Question: Write a caption explaining this figure to a reader.
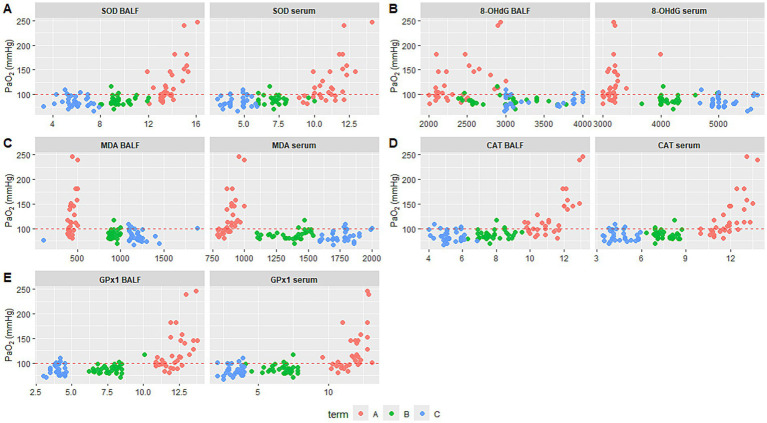
Answer: Repeated-measures correlations between arterial oxygen tension (PaO 2 ) and oxidative stress markers and antioxidant enzyme concentrations in serum and bronchoalveolar lavage fluid (BALF). Correlations are shown for (A) superoxide dismutase (SOD), (B) 8-hydroxy-2′-deoxyguanosine (8-OHdG), (C) malondialdehyde (MDA), (D) catalase (CAT), and (E) glutathione peroxidase 1 (GPx1). Measurements were obtained at three time points: within 6–8 h after injury (red), on day 3 (green), and on day 7 (blue). Each point represents an individual patient measurement. The red dashed horizontal line indicates a PaO 2 value of 100 mmHg.